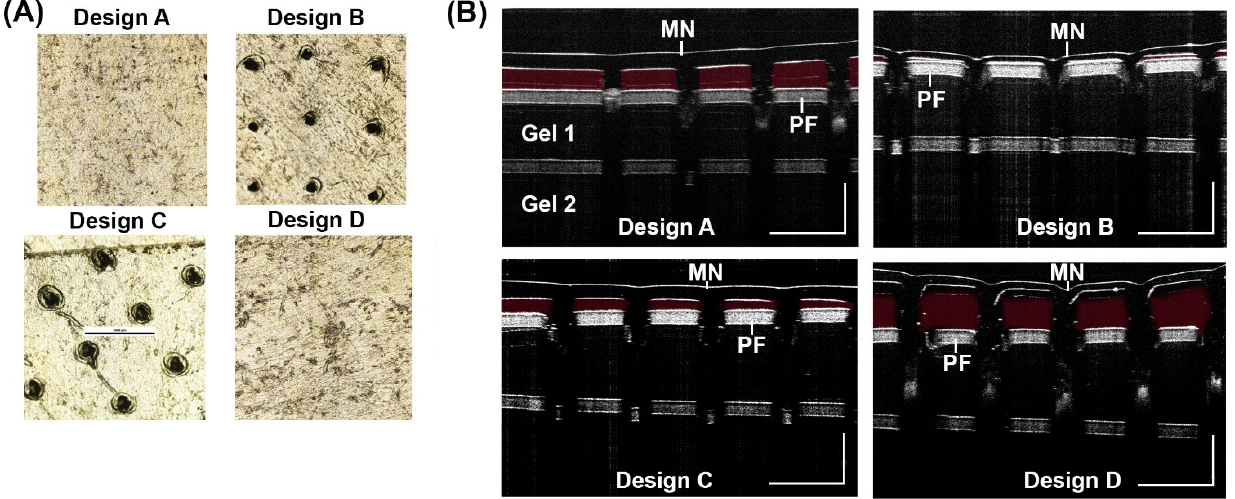
Figure 4. Penetration test for MN designs. ( A ) PF penetration to the 3rd layer was imaged on a light microscope for the four designs. ( B ) OCT 2D cross-sectional (B-scan) images were taken of each MN design after insertion into a 2% ( w / w ) gel with a one sheet of PF on top of the gel, a sheet of PF below gel 1, and another 2% ( w / w ) gel below the second sheet of PF (gel 2). Scale bar 1000 μ m.